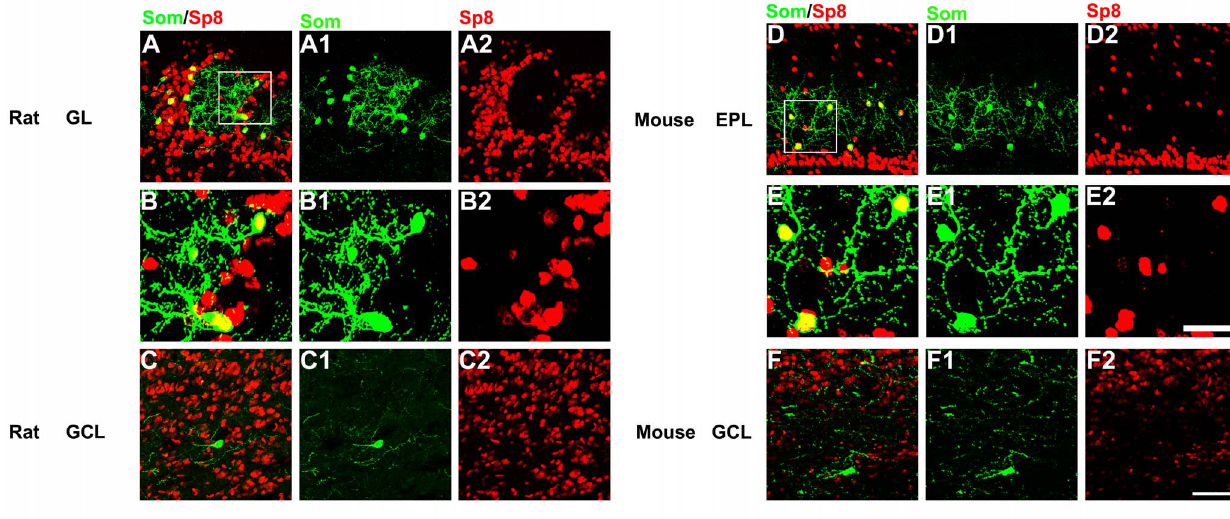
Figure 1. Virtually all of the Som + cells express Sp8 in the OB. (A) The Som + cells in the GL of the adult rat OB express Sp8. (B) High magnification of the boxed areas in A showing the Som + /Sp8 cells. (C) The Som + cells with a larger soma in the GCL do not express Sp8 in the rat OB. (D) The Som + cells in the EPL of the mouse OB express Sp8. (E) High magnification of the boxed areas in D showing the Som + /Sp8 + cells. (F) The Som + cells with a larger soma in the GCL do not express Sp8 in the mouse OB. Scale bars: 50 m m (in F2 applies to A, C, D and F), 20 m m (in E2’’ applies to B and E).